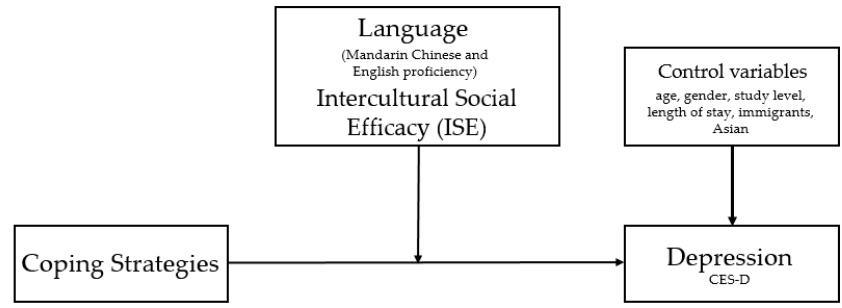
Figure 1. Theoretical framework of the study.